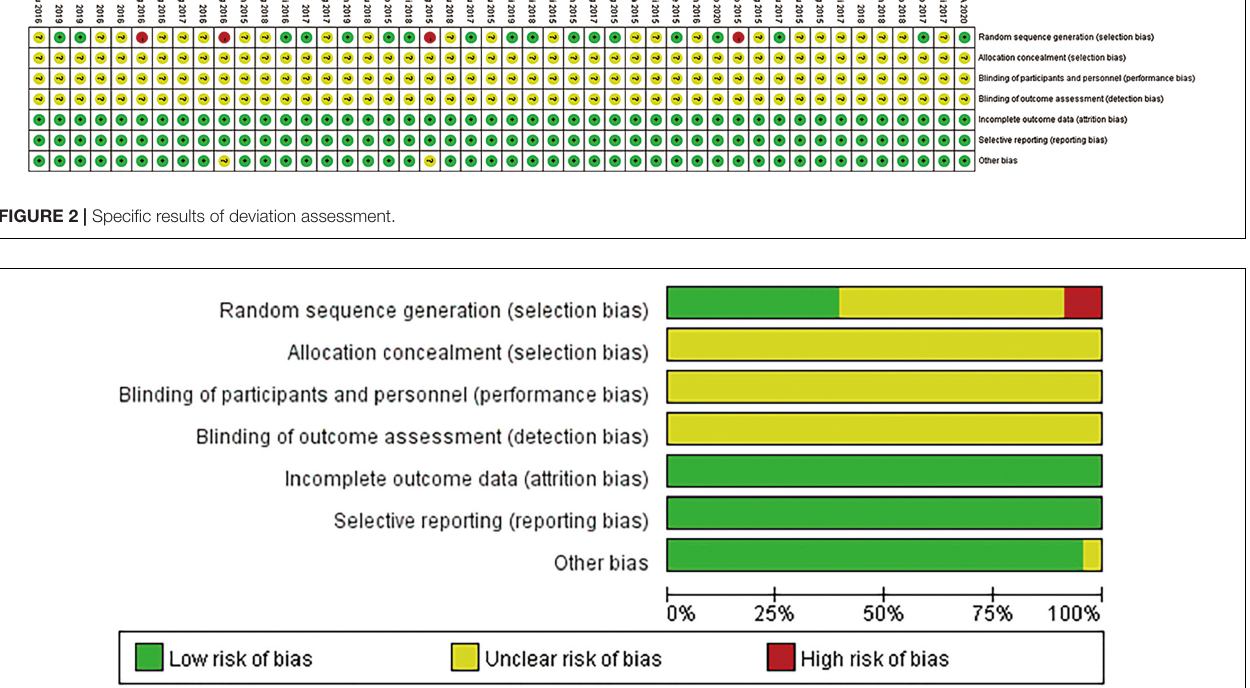
FIGURE 3 | Schematic diagram of methodological quality assessment of the literature in this